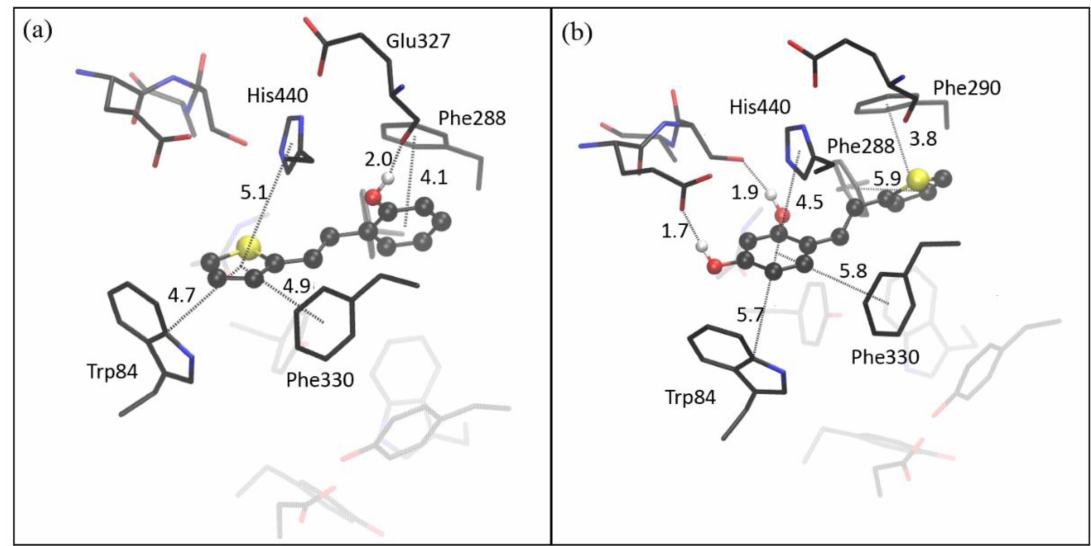
Figure 8. The structure of the active site of AChE docked with II ( a ) and III ( b ). Hydrogens omitted for the sake of